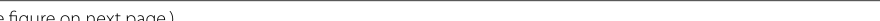
figure on next Fig. 2 Aberrant production of IL‑6 by the patient’s blood leukocytes. Density gradient‑purified peripheral blood mononuclear cells were left unstimulated (unstim) or stimulated for 24 h with anti‑CD3 anti‑CD28, lipopolysaccharide (LPS) adenosine triphosphate (ATP), L18‑muramyl + + dipeptide (L18‑MDP), poly(deoxyadenylate–thymidylate) [poly(dA:dT)], anisomycin or the pro‑inflammatory cytokines IL‑1β, TNF, IFN‑γ and IL‑6 to respectively activate T cells, the NLRP3, NOD2, AIM2 and pyrin inflammasomes as well as cytokine signalling. Concentrations of IL‑6, TNF, IL‑12, IL‑23, IL‑1α, IL‑1β, IL‑18, IL‑1RA, IL‑17 and IFN‑γ were determined by multiplex assays in the cells’ supernatants of healthy donors (black dots) and the patient with aggressive RA‑like PsoA (red square). Results are expressed as mean standard deviation for the healthy donors (n 5). ND; not ± =